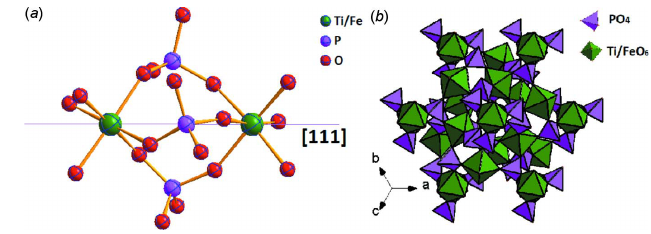
Figure 2 ( a ) [(Ti/Fe) 2 (PO 4 ) 3 ] building unit and ( b ) three-dimensional framework for (I) and (II).